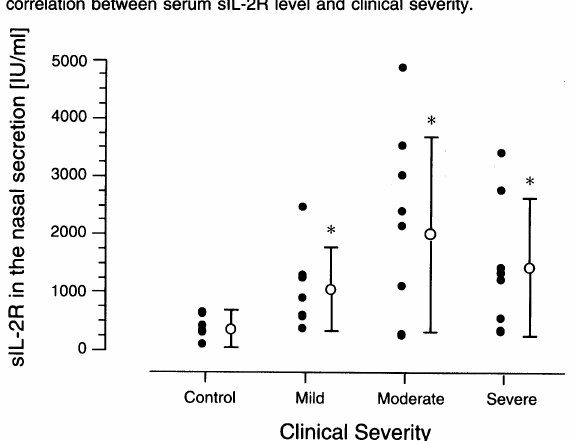
FIG. 3. Immunostaining of the nasal mucosa obtained from the inferior turbinate of a nasal allergy patient for CD25 (IL-2R). CD25 cells formed a cluster in superficial lamina propria. (Original magnification x